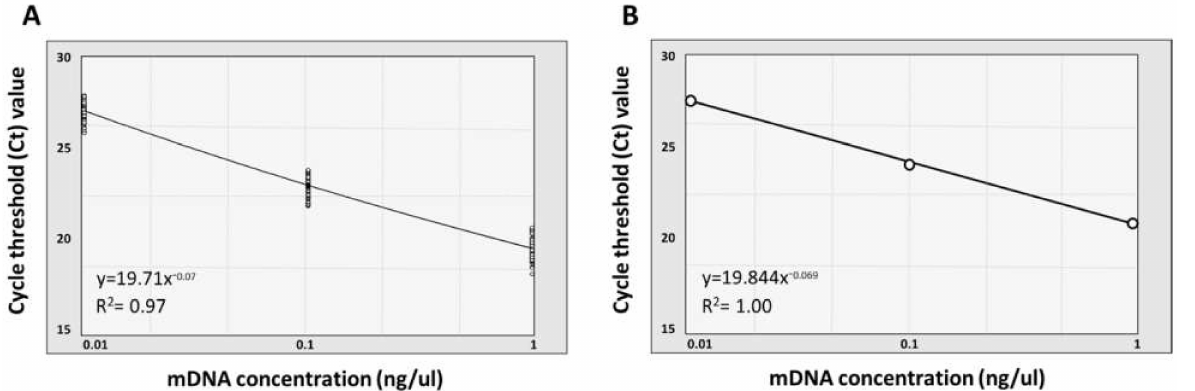
Figure 2. Standard curve calculation to confirm normalization of the mDNA concentration used for qRT-PCR analysis. Each double-stranded mDNA sample diluted with a three step 10-fold serial dilution (10 − 1 , 10 − 2 , and 10 − 3 ) was standardized at 10 ng/ µ L for standard curve calculation. The graph’s x -axis indicates the concentration of each 10-fold diluted mDNA used in standard curve calculation, and the y -axis shows the Ct value measured from the qRT-PCR. ( A ) Standard curve graph representing the Ct value of every sample with 10-fold serially diluted mDNA concentration (R 2 = 0.97). ( B ) Standard curve graph representing the average Ct value of each concentration of the diluted mDNA sample (R 2 =